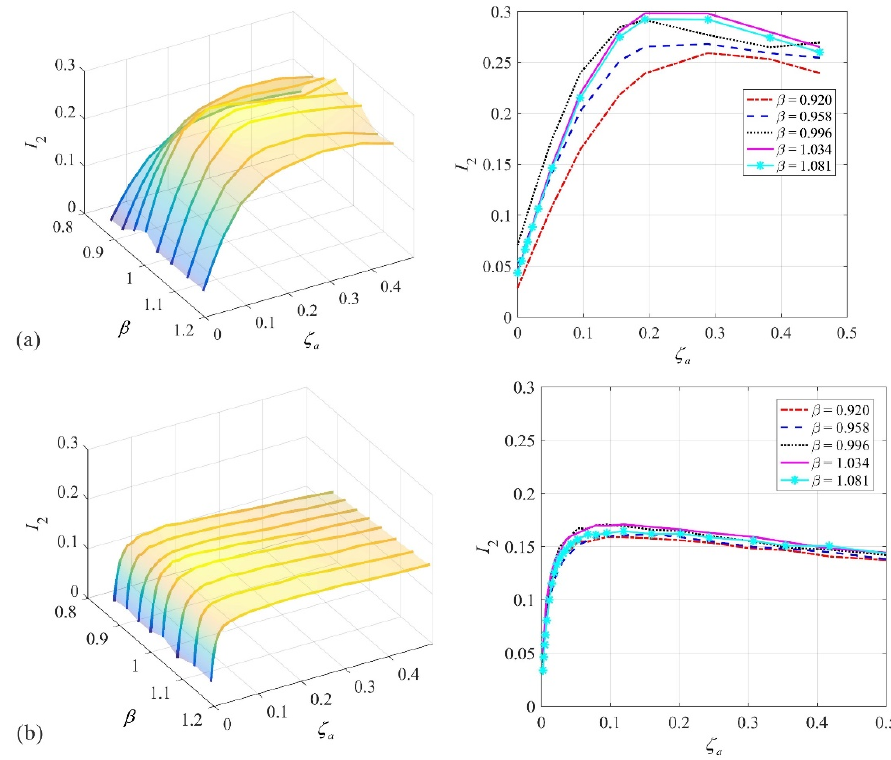
Figure 18. 3D and 2D plots of I 2 with µ = 0.154: ( a ) experimental result; ( b ) simulation result.